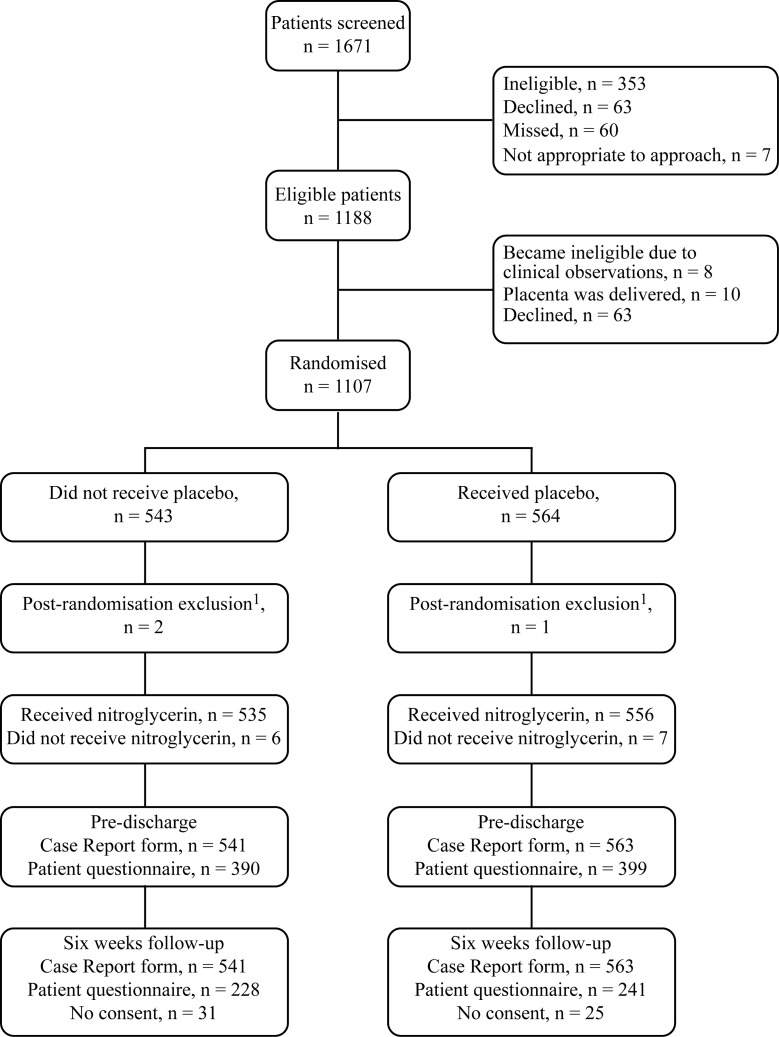
CONSORT diagram for GOT-IT trial.1Reasons for post-randomisation exclusions were (1) eligibility could not be confirmed as the last observations were taken approximately 1 hour prior to the study drug being given; (2) the inclusion criteria observations were not documented; and (3) the participant consent form was lost and there were no eligible observations documented.